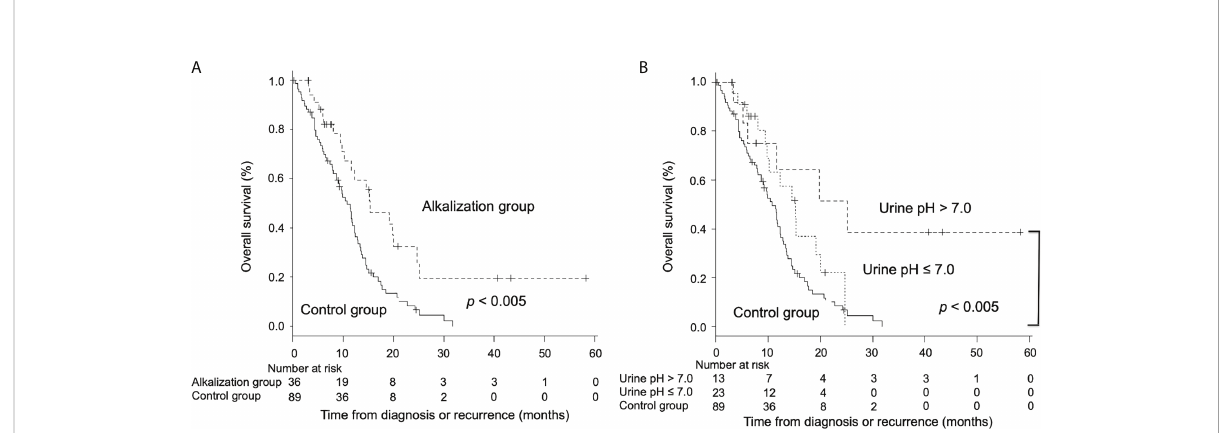
FIGURE 2 Overall survival between advanced pancreatic cancer patients who were treated with alkalization therapy plus chemotherapy and those who were treated with chemotherapy only. Kaplan – Meier curves of the OS of the alkalization group and the control group are shown. (A) The median OS of the alkalization group was signi fi cantly longer than that of the control group. (B) In patients with an increased urine pH (pH > 7.0), a more prolonged median OS was observed than in the control group. [Adapted from reference